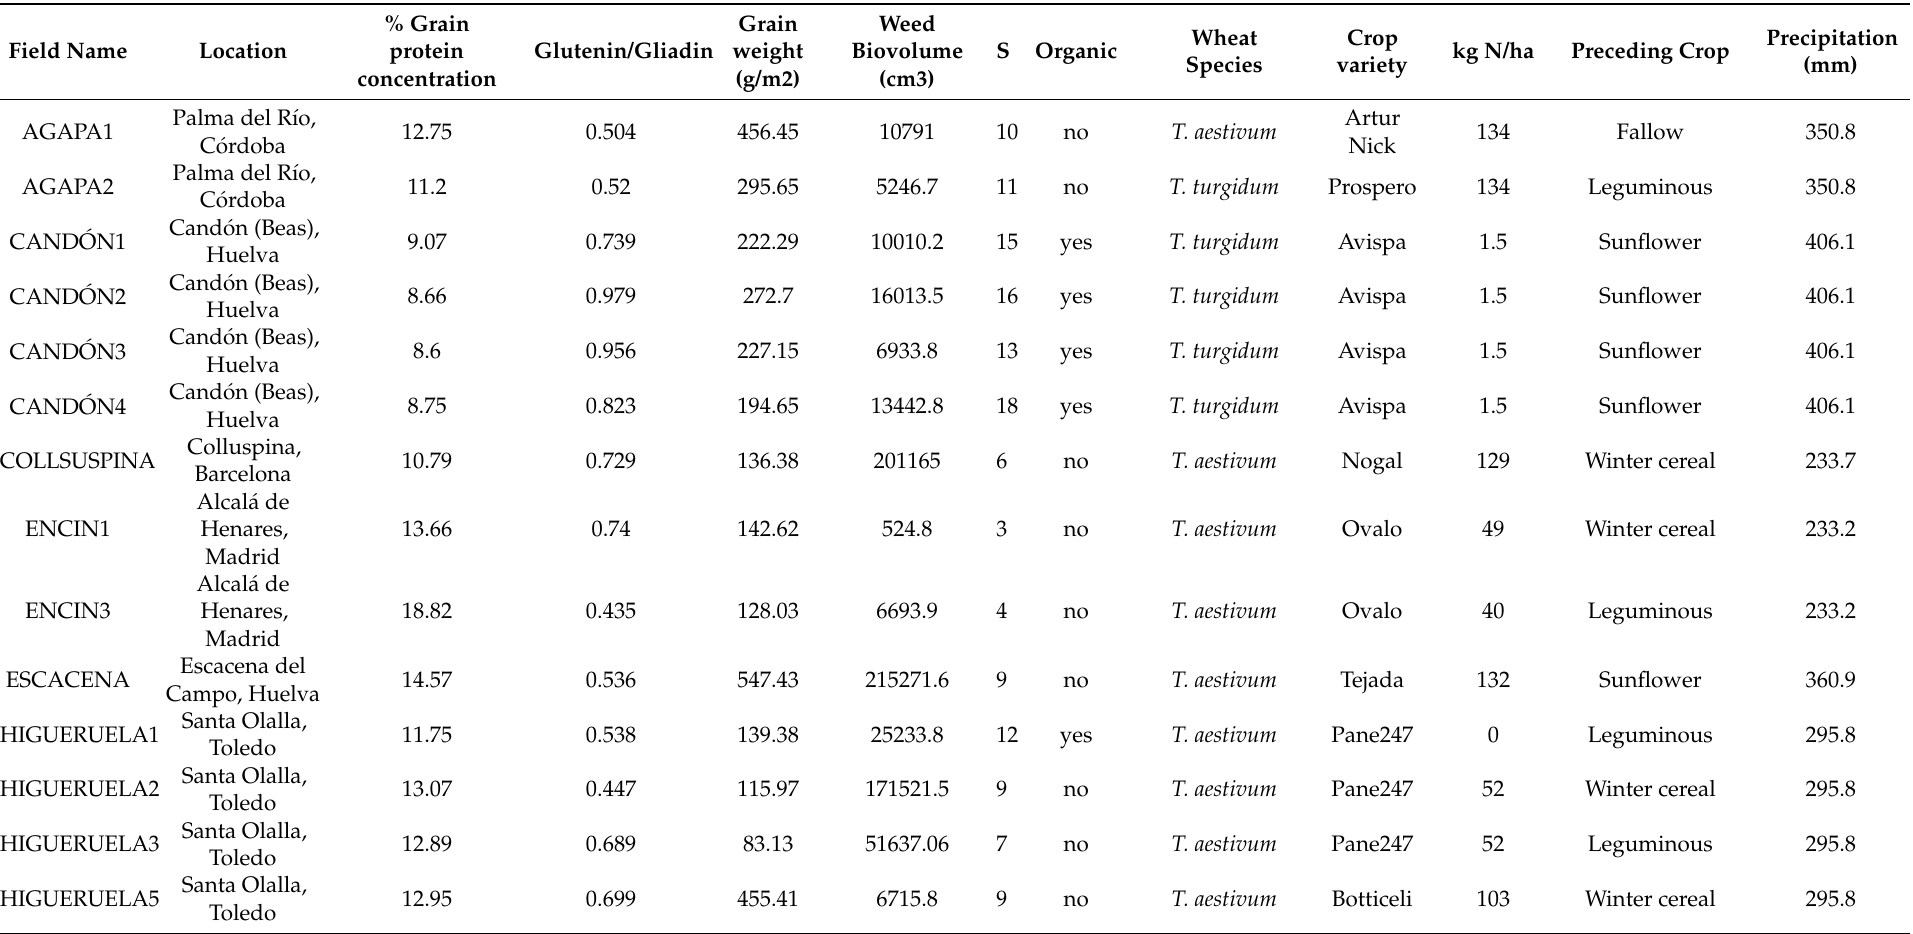
Table 1. Fields sampled in the study: location and average value, across the 10 plots per field, of the percentage of wheat grain protein concentration, the glutenin to gliadin ratio, the crop grain weight, the weed biovolume (see text for details) and weed species richness (S). We also include whether the field was managed organically or not (organic), the wheat species and the variety, the fertilization rate (expressed as kg of N/ha), the preceding crop of each field as well as the total precipitation during the crop season (dates varying between fields; see